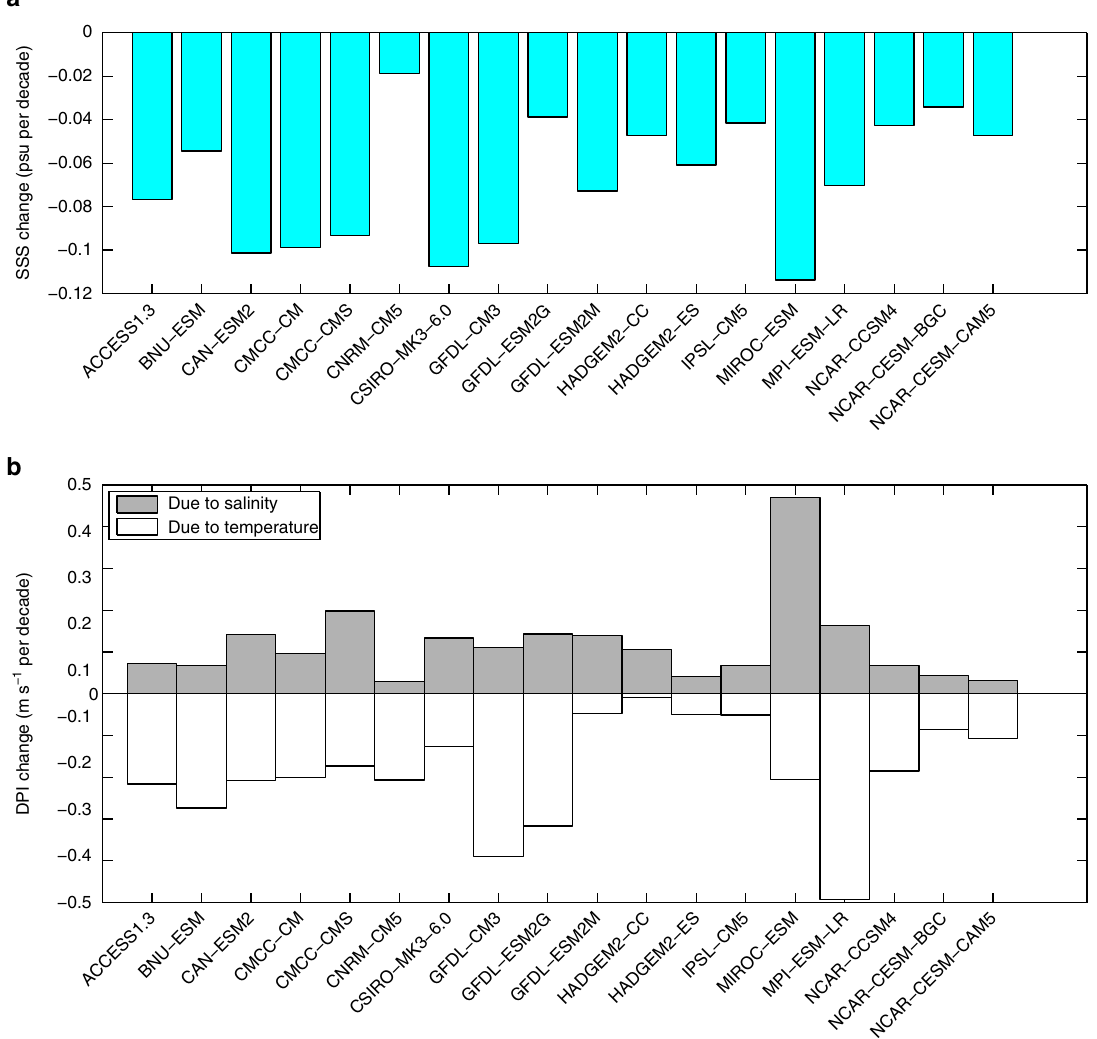
Figure 4 | Inter-model spread in CMIP5 projections. Changes in ( a ) Sea Surface Salinity (SSS) in psu per decade and ( b ) Dynamic Potential Intensity (DPI) due to salinity (grey) and due to temperature (white), in ms (cid:2) 1 per decade, projected by 18 CMIP5 climate models under the RCP 8.5 scenario. SSS and DPI are averaged over the typhoon season (June–November) and over the region 130 (cid:2) E–150 (cid:2) E and 5 (cid:2) N–25 (cid:2) N (see box in Fig. 1a). In a , b , change is defined as the difference between the mean over the 20-year periods 2081–2100 and 1981–2000.